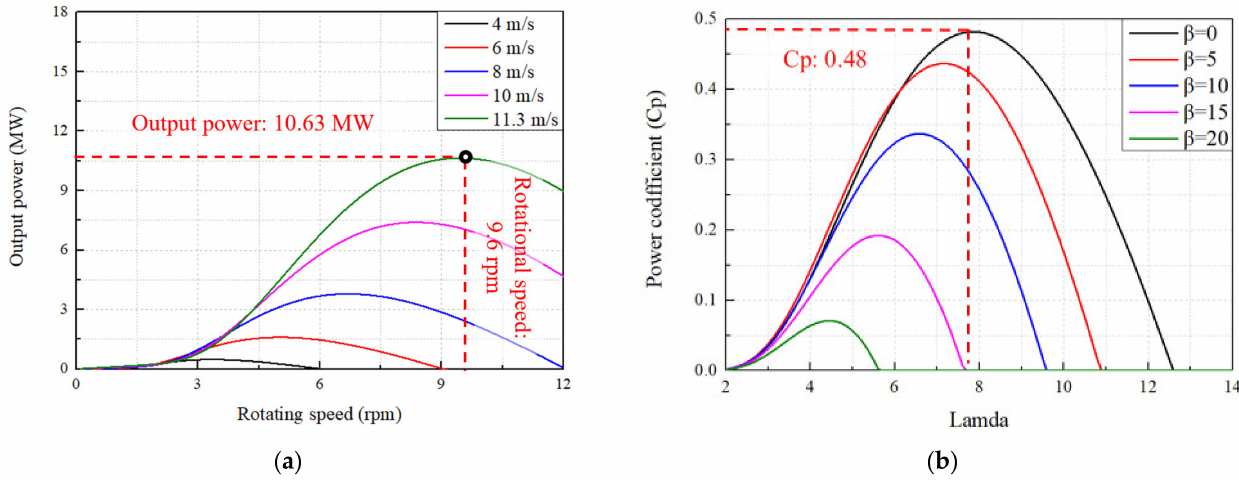
Figure 2. ( a ) Maximum power extraction curve of the 10 MW FOWT according to the rotating speed under the different absolute wind speeds; ( b ) Power coefficient curves with blade angle